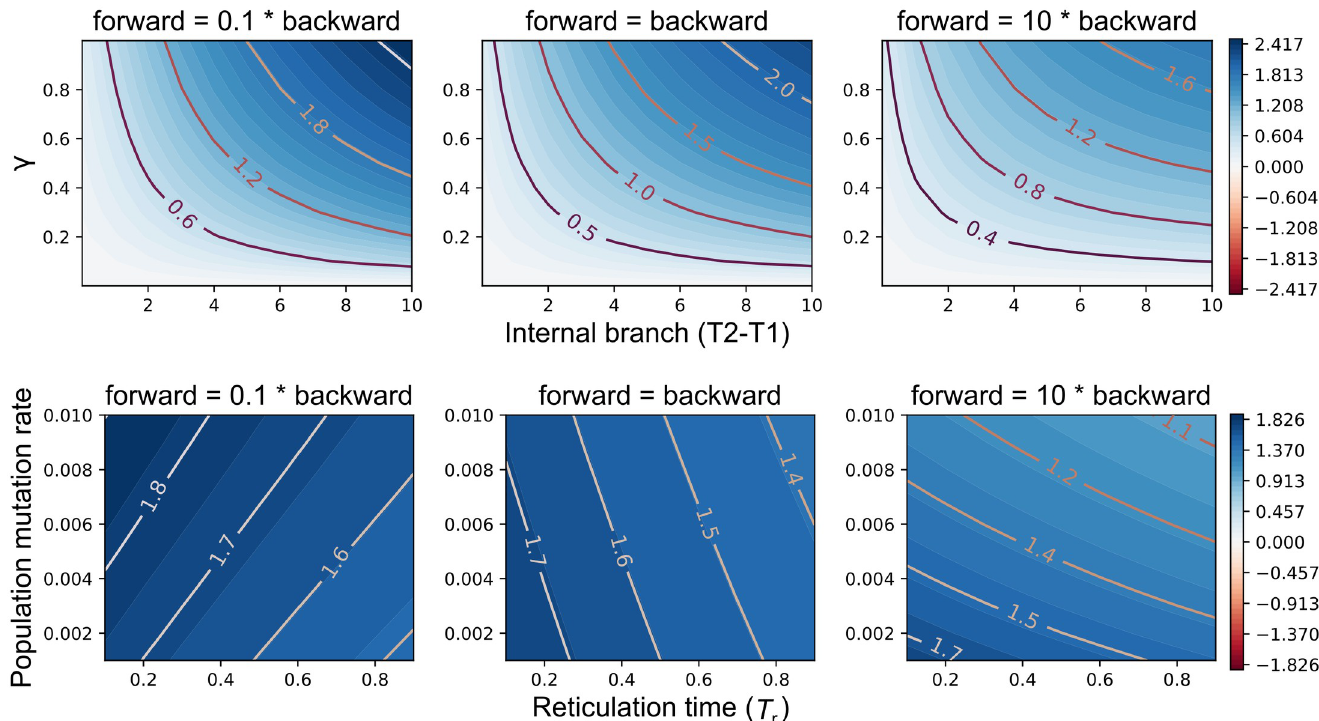
Fig 2. The interaction of evolutionary parameters affects the need for introgression to explain trait patterns. G-XRF is shown as a function of internal branch length T 2 − T 1 and inheritance probability γ when reticulation time T r = 0.1 coalescent units and population mutation rate θ = 0.01 (top row), and as a function of θ and T when T 2 − T 1 = 10 and γ = 0.5 (bottom r